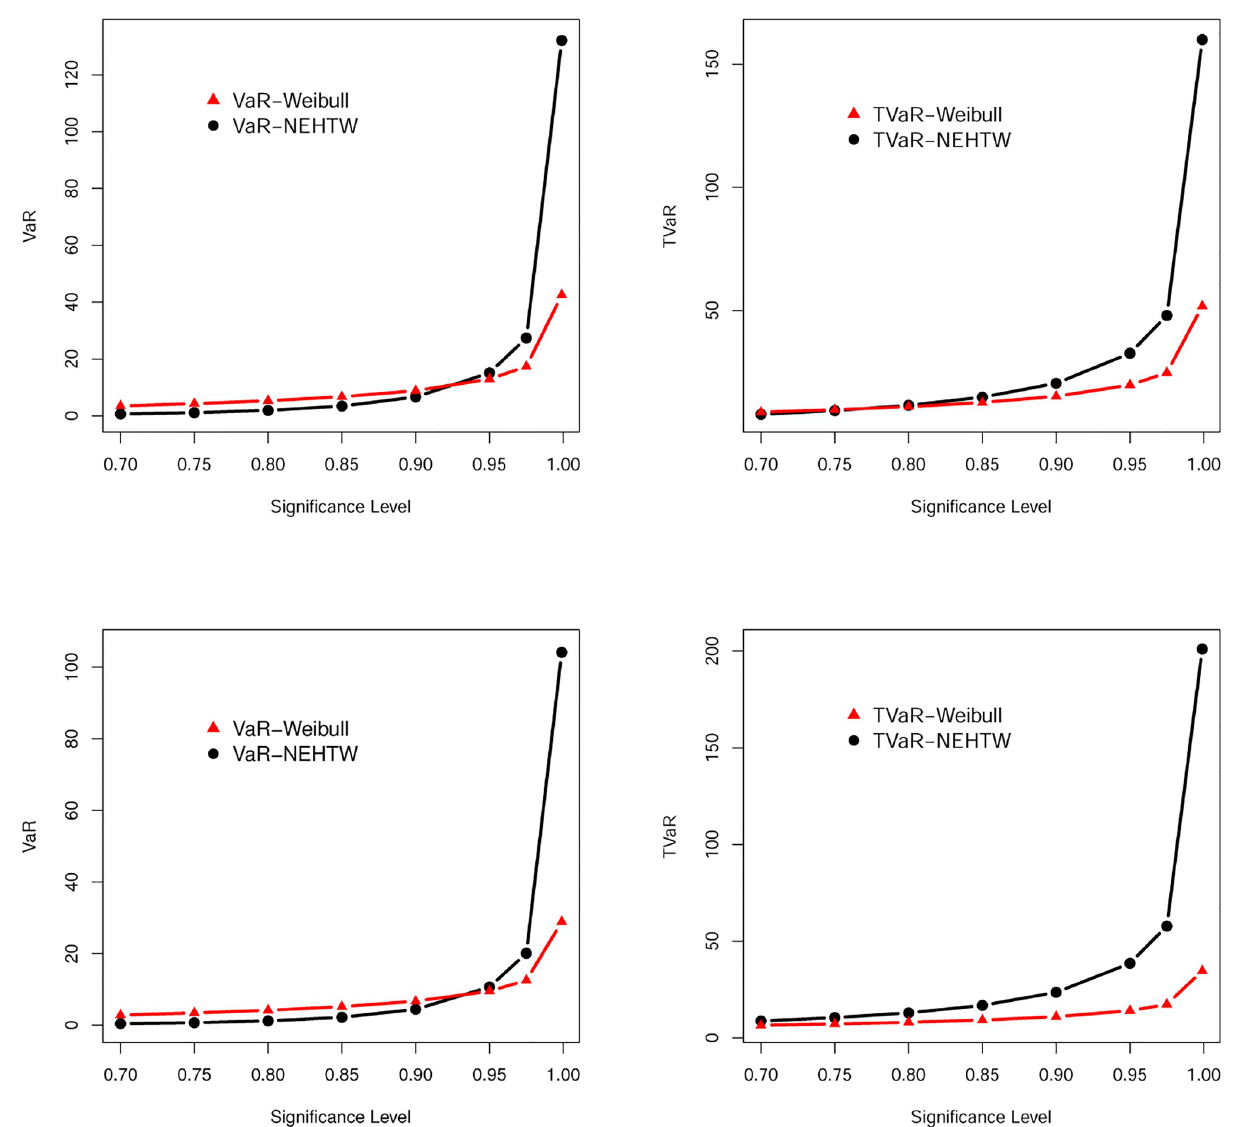
Fig 4. Shapes of the VaR and TVaR of the NEHTW and Weibull distributions based on Tables 1 and 2.